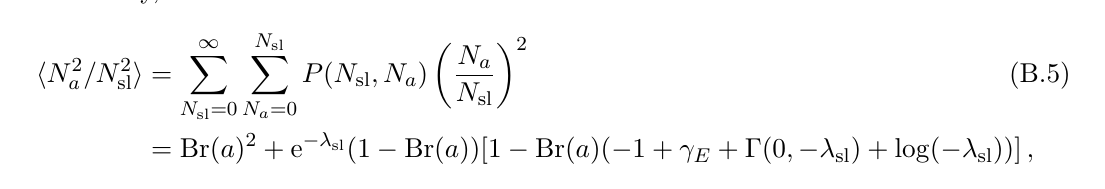
Figure 12 . Number of events expected at the ILC with p CEPC with s = 90 GeV (bottom line) in case of both normal ordering (left column) and inverted ordering (right column) for parameter points consistent with